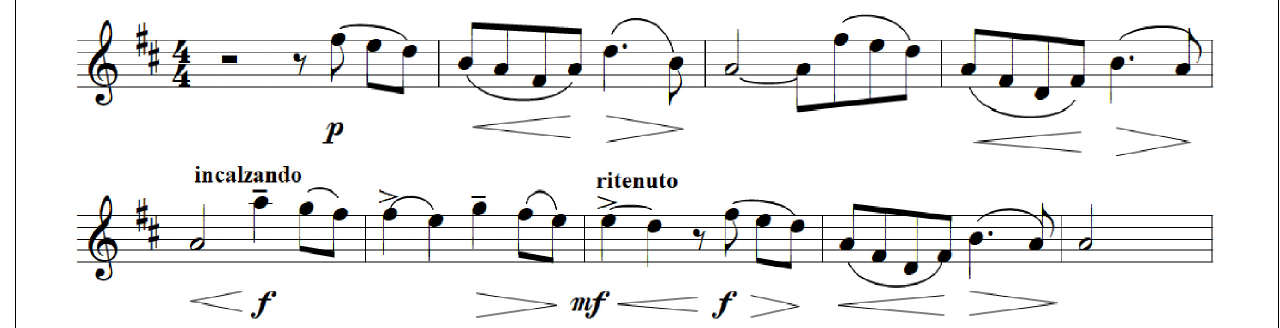
FIGURE 1 | Andante from the 1st movement, Tchaikovsky’s Pathétique Symphony, measures 89–97 (Violin I). Audio version, Musopen Orchestra, Supplementary Audio 1 .